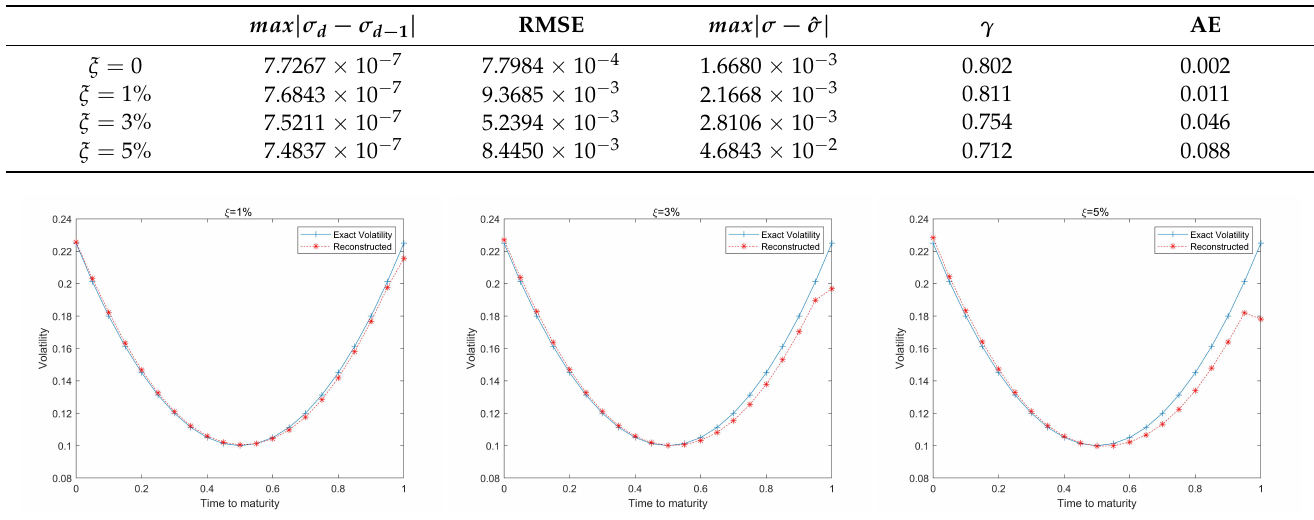
Figure 4. Recovered volatility function against exact one for Example